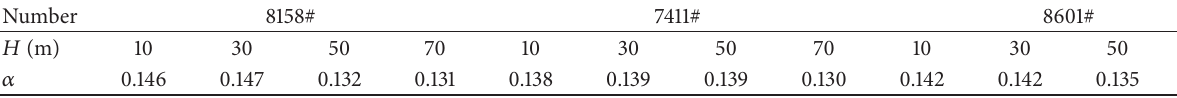
Table 6: Results of wind shear at different heights.